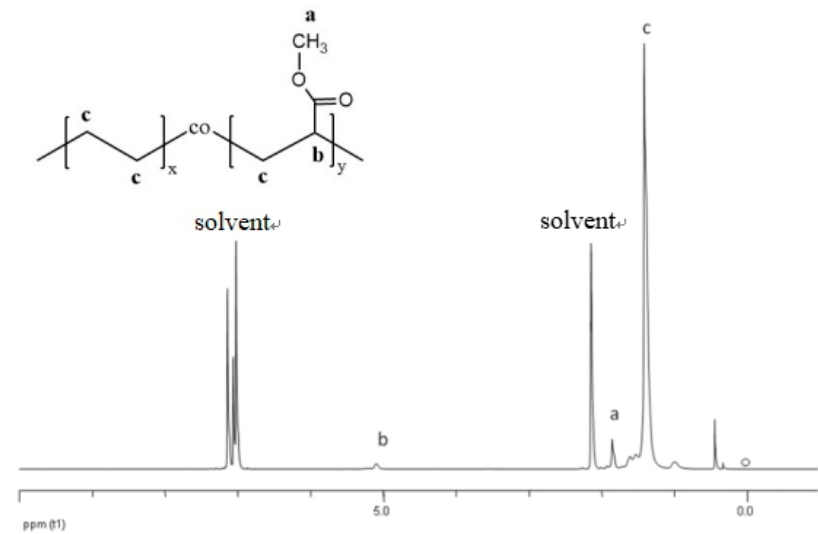
Figure 3. 1 H ‐ NMR spectrum of cPEVA31 with assigned chemical shifts. a: –CH3 (protons from methyl